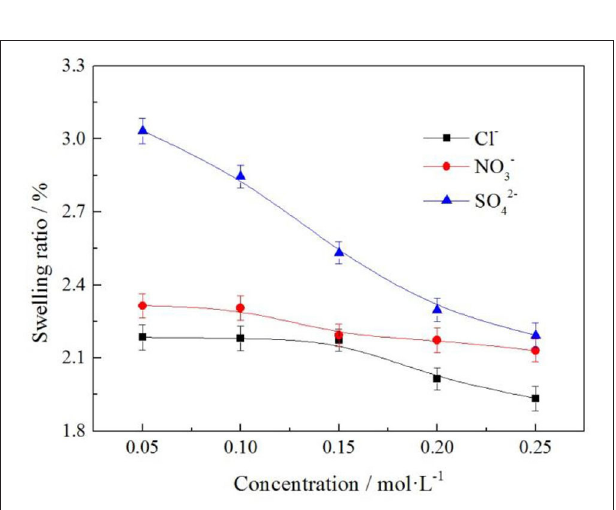
FIGURE 13 | Effect of anion on swelling ratio of clay